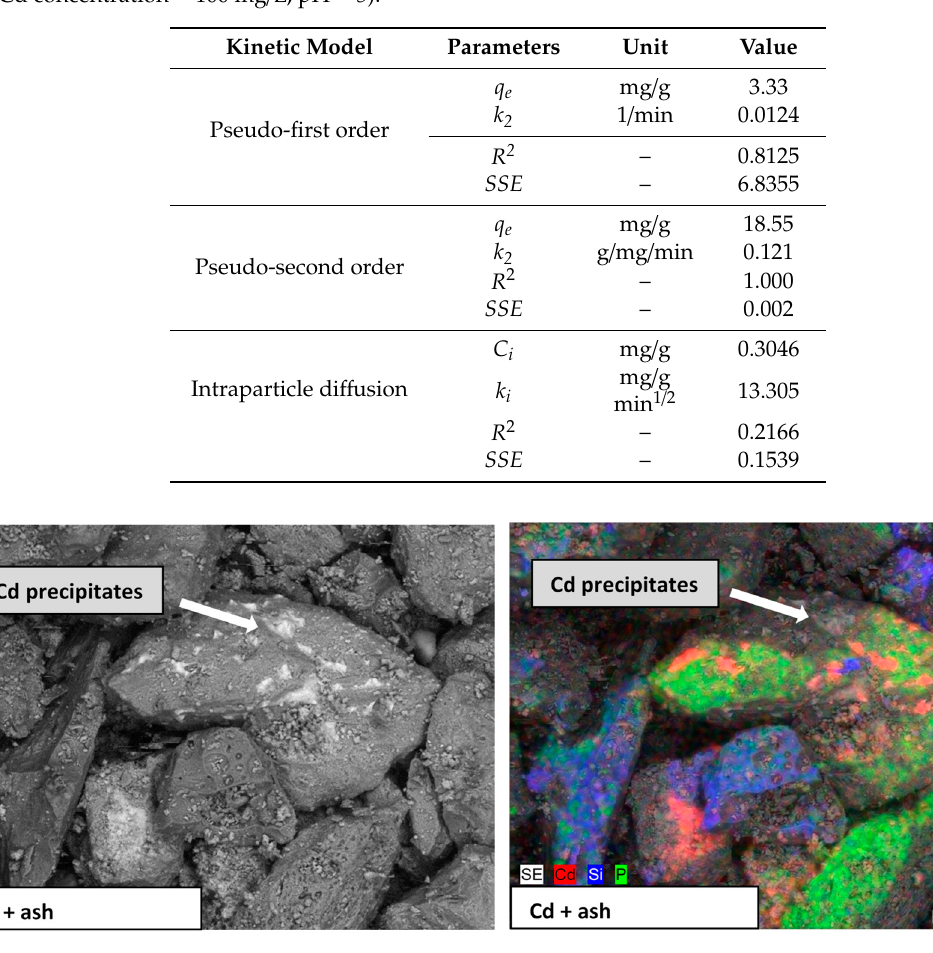
Figure 11. SEM micrographs of poultry ash after Cd adsorption. Minerals 2020 , 10 , x FOR PEER REVIEW